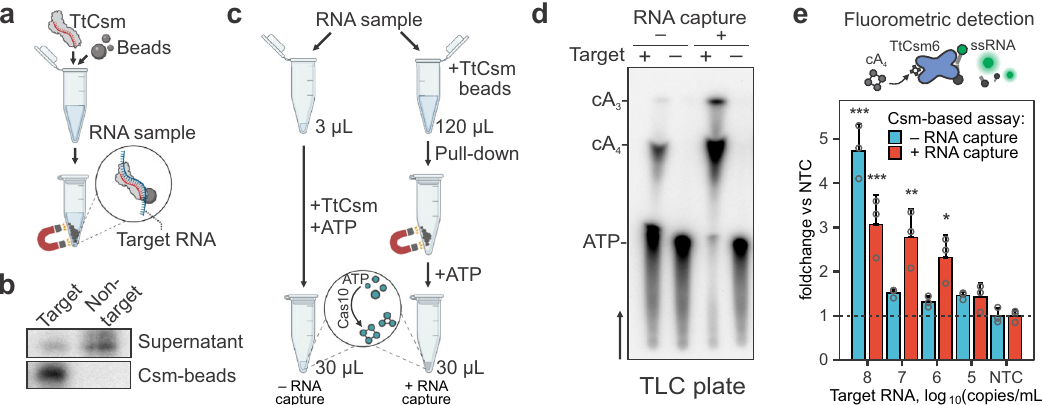
Fig. 1 | Type III CRISPR-based RNA concentration enhances sequence-speci fi c detectionofRNA.a SchematicoftypeIIICRISPR-basedRNAconcentration.RNase- dead type III CRISPR complex from Thermus thermophilus (e.g., TtCsm Csm3-D34A ) is added to a sample to bind complementary “ Target RNA ” . The His-tagged complex is concentrated using nickel-derivatized magnetic beads and a magnet. b Sequence-speci fi cRNAenrichmentwithTtCsm Csm3-D34A wastestedusing25nM 32 P 5 ‘ -end labeled RNA. Target or non-target RNA fragments were mixed with His- tagged TtCsm Csm3-D34A complex (125nM) and concentrated with nickel-derivatized magnetic beads. Phenol-chloroform extracted RNAs from the supernatants and Csm-beads were resolved using UREA-PAGE. c Csm-based direct RNA detection using3 μ LofsampleiscomparedtoanassaywhereTtCsm Csm3-D34 isusedtocapture RNA at the same concentration from a 120 μ L volume. Magnetic beads decorated with TtCsm Csm3-D34A are added to the sample. After concentrating beads with a magnet, the supernatant is decanted, and he pellet is resuspended in a reaction buffer with ATP to activate polymerase activity of Cas10. Polymerization products